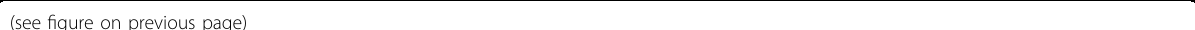
Fig. 3 Impairments of neocortical development in Zbtb16 KO mice. a Zbtb16 KO mice show smaller brains than WT mice. b Representative images showing thinner neocortical thickness in primary somatosensory (S1) cortex of Zbtb16 KO mice. c Representative fl uorescent images of CTIP2 + and TBR1 + neurons in the S1 cortex. d Quanti fi cations of neocortical thickness by DAPI staining. A signi fi cant reduction of neocortical thickness was observed in the S1 cortex of Zbtb16 KO mice. e , f Quanti fi cation of deep layer thickness by co-immunostaining of CTIP2, a marker for layer 5 (L5) ( e ) and TBR1, a marker for L6 ( f ). Neocortical L6 was speci fi cally thinner in Zbtb16 KO mice. g , h Quanti fi cation of CTIP2 + ( g ) and TBR1 + ( h ) cells in the mouse S1 cortex. The number of TBR1 + L6 neurons were speci fi cally decreased in the S1 cortex of Zbtb16 KO mice. i Representative images of dendritic spines by Golgi staining. j Quanti fi cation of dendritic spines of L5 neurons in the mouse PFC (M1 cortex). k Representative fl uorescent images of IBA1 + microglia in the PFC. l Quanti fi cation of IBA1 + microglia the upper layer (L1-4) of mouse PFC. Signi fi cant increases of dendritic spines ( j ) and IBA1 + microglia ( l ) were observed in the PFC of Zbtb16 KO mice. m Representative fl uorescent images of myelination in the PFC by MBP immunostaining. n , o Representative fl uorescent images of PDGFR α + or APC + oligodendrocytes in the PFC. p Quanti fi cation of the proportion of myelinated neocortex. Immature myelin formation was observed in the PFC of Zbtb16 KO mice. q , r Quanti fi cations of oligodendrocyte in the PFC. Signi fi cant reductions of PDGFR α + oligodendrocyte progenitors ( q ) and APC + mature oligodendrocytes ( r ) were observed in the PFC of Zbtb16 KO mice. Insets show a higher magni fi cation of the boxed area depicted in each fl uorescent image. Data are represented as means (±SEM). Asterisks indicate **** P < 0.0001, ** P < 0.01, * P < 0.05, unpaired t-test. n = 5 – 6/condition for length and cell count, n = 10 cells/condition from 5 – 6 mice for the dendritic spine. Scale bars: 1000 μ m in a , 300 μ m in b , c , k , m – o , 75 μ m in insets of c , k , n , o , 10 μ m in i